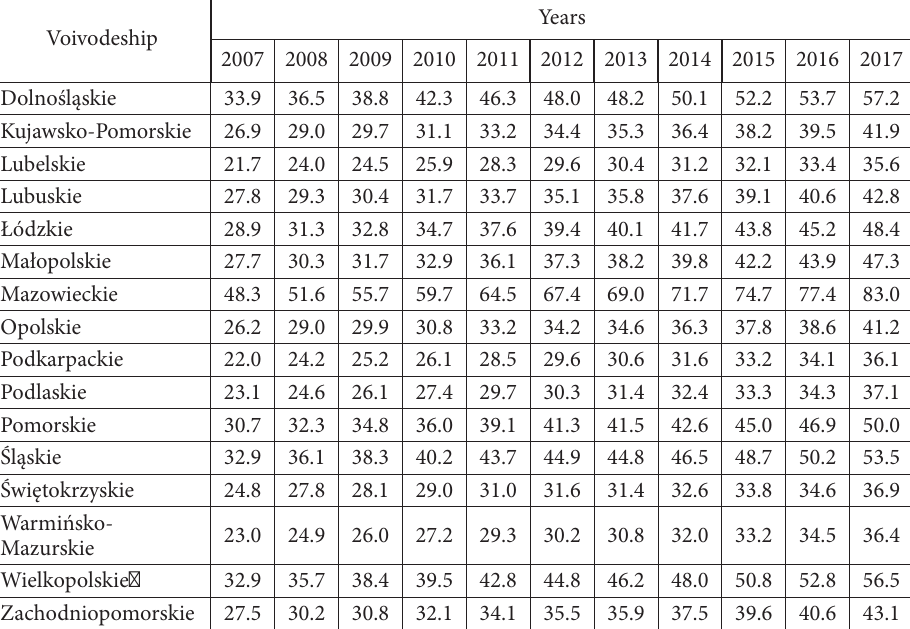
Table 1. GDP per capita in voivodeships in thousands PLN (source: Statistics Poland, n.d.)